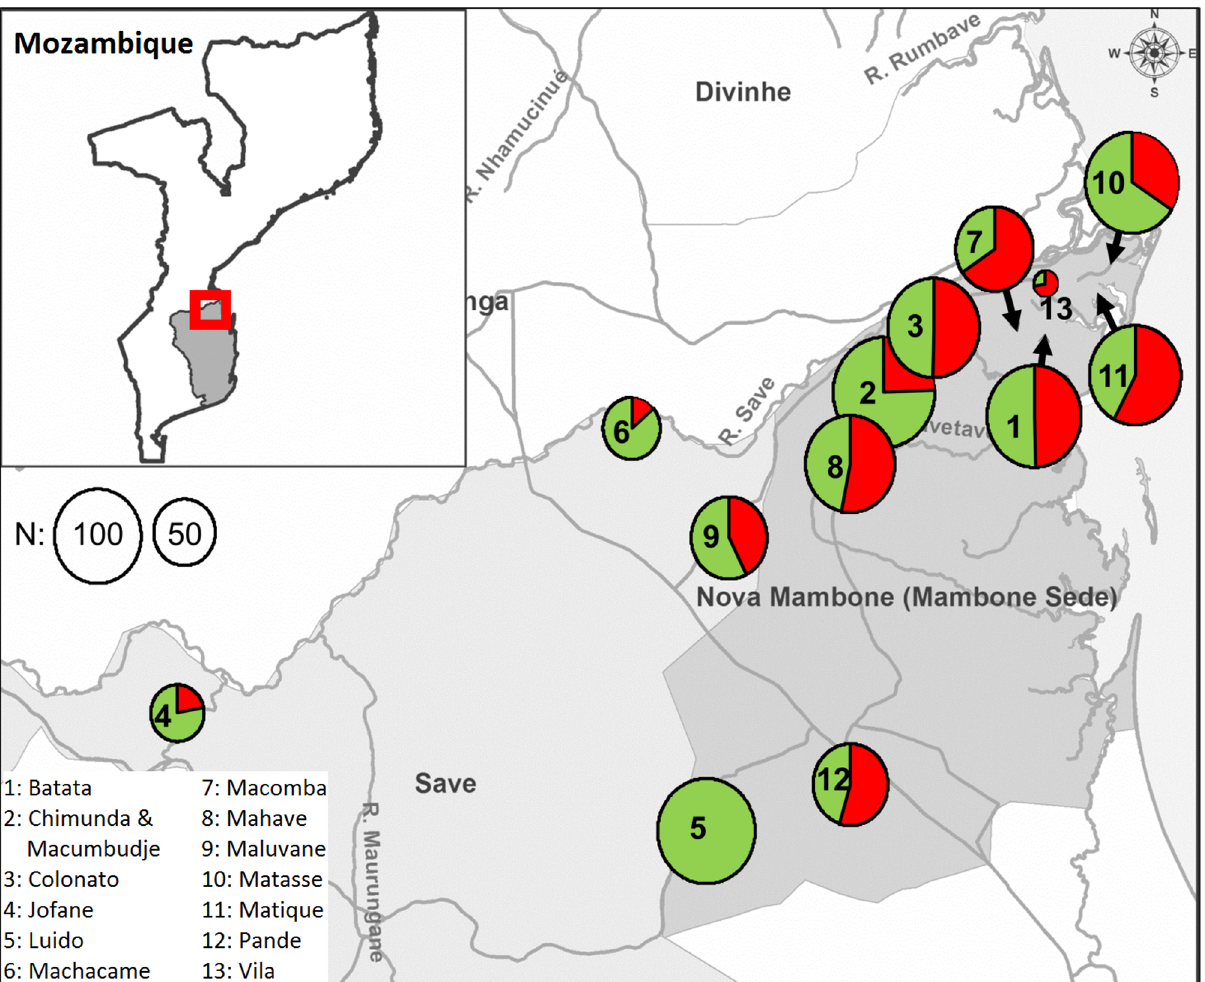
Figure 1. Location of the study district Govuro and spatial distribution of positive reactor cattle. The circle size is proportional to the number of animals tested in each location, and red area denotes the proportion of positive animals.